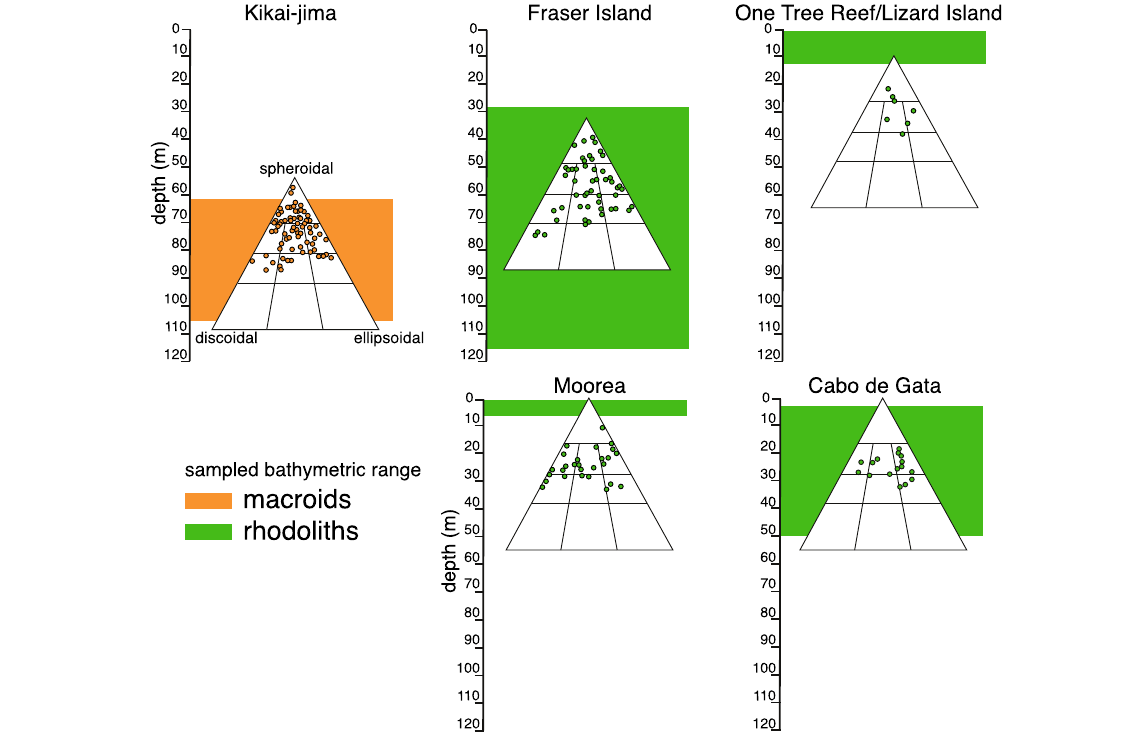
Fig. 1 Macroid and rhodolith sphericity in the studied beds from Kikai-jima, Fraser Island, One Tree Reef/Lizard Island, Moorea, and Cabo de Gata. The sampled bathymetric range of the studied beds is also reported (colored depth intervals). No variation in sphericity with increasing depth is